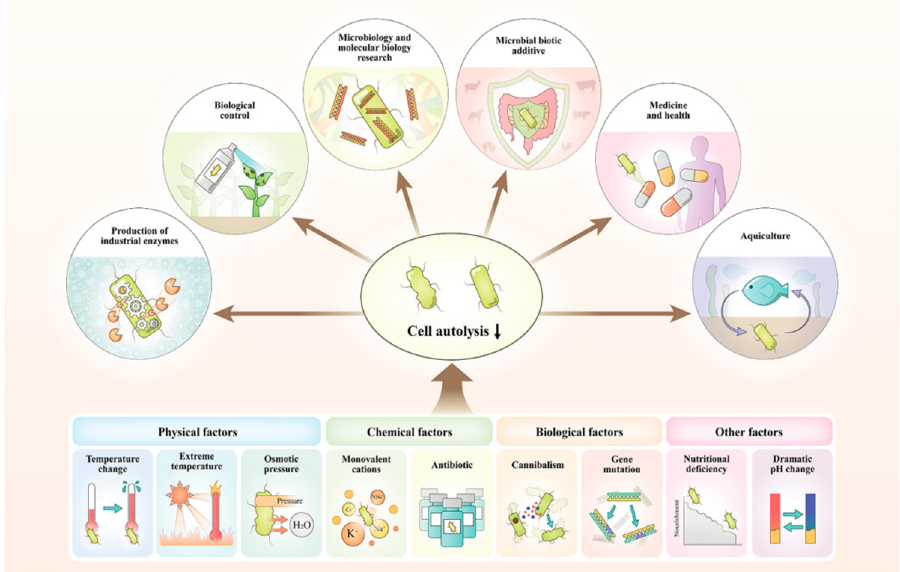
Figure 1. Application of B. subtilis as industrial production chassis and factors related to autolysis of B. subtilis